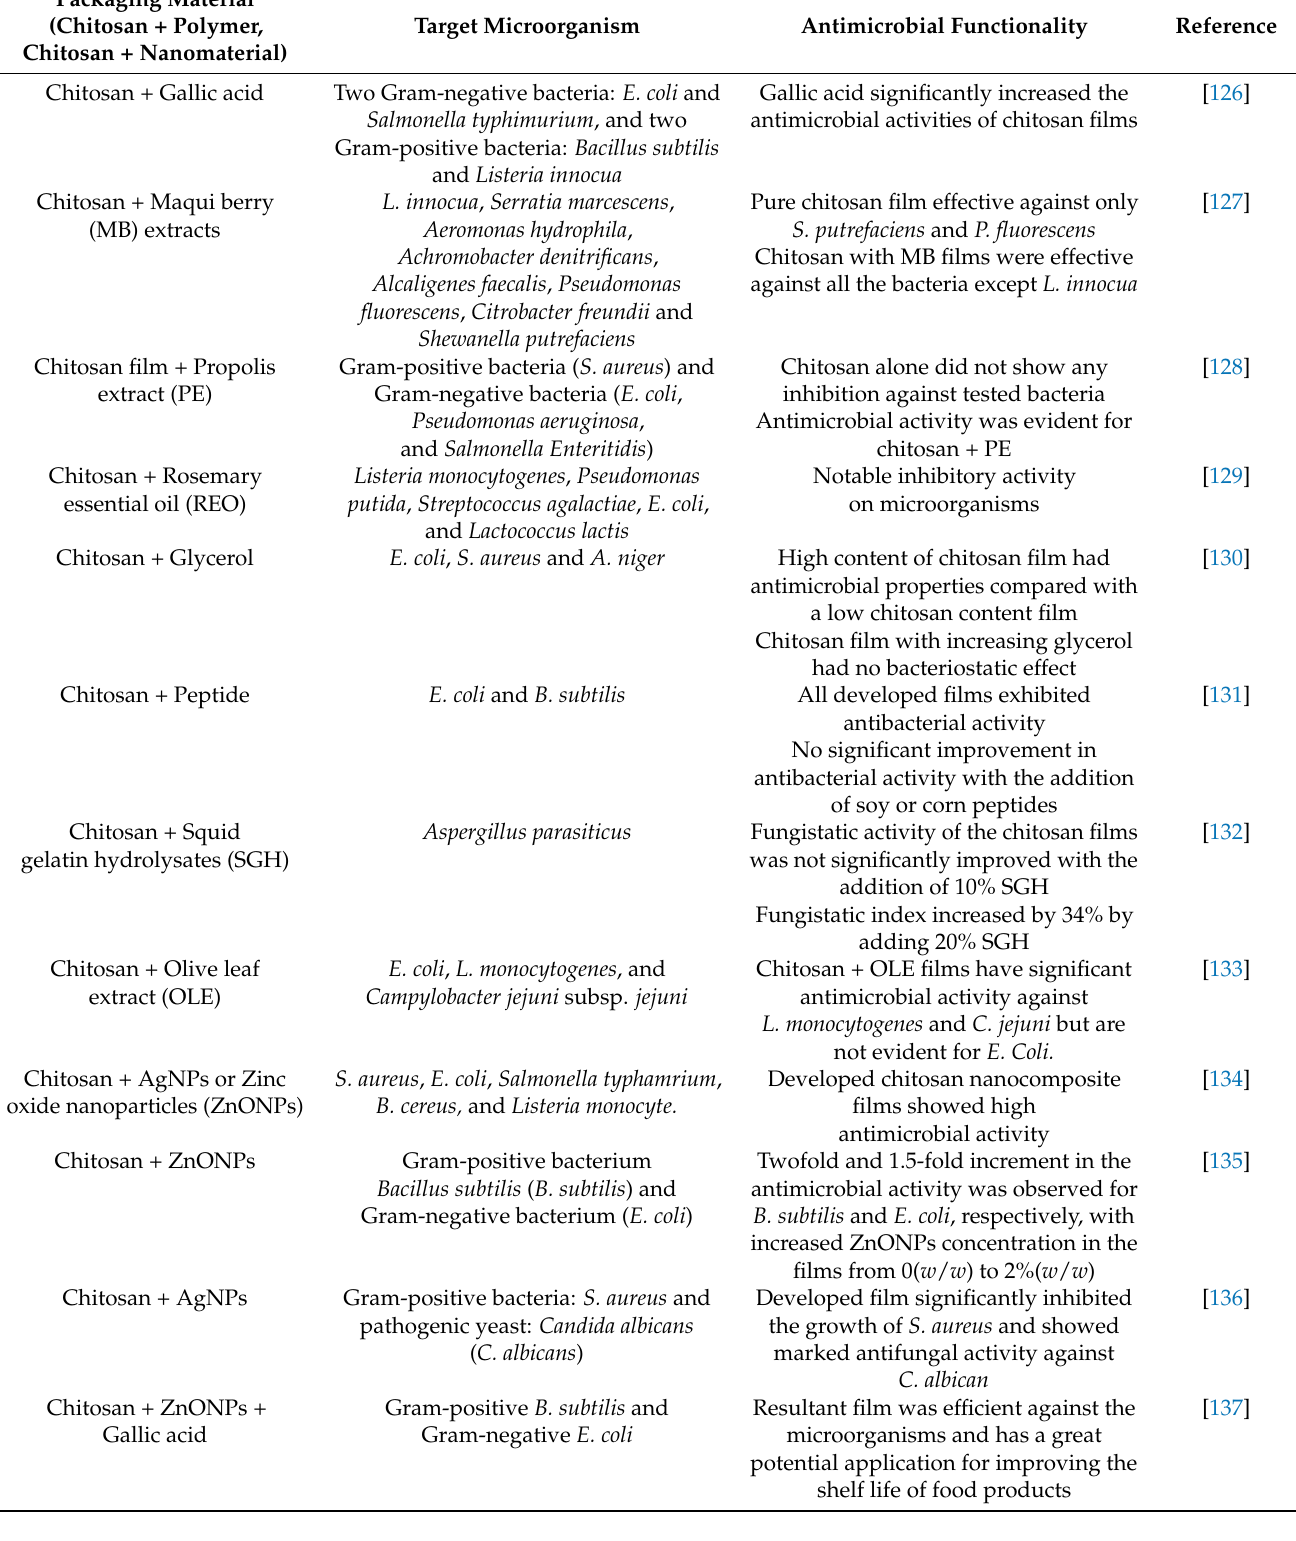
Table 2 highlights examples of chitosan films enhanced with polymers and nanomaterials. Table 2. Some examples of studies with chitosan film enhanced with polymers and